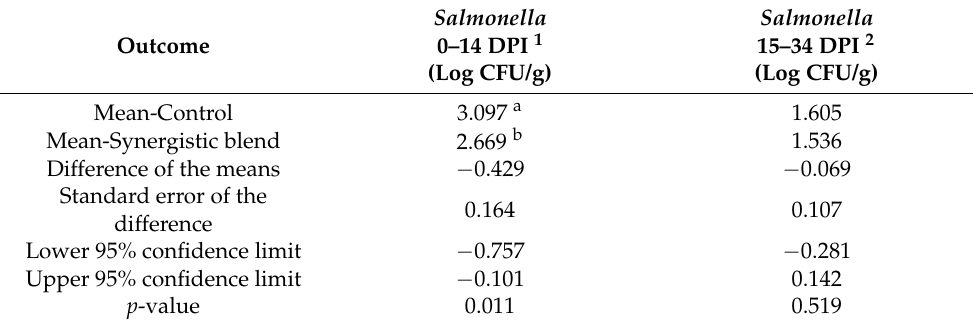
Table 2. Meta-analysis of cecal Salmonella counts.